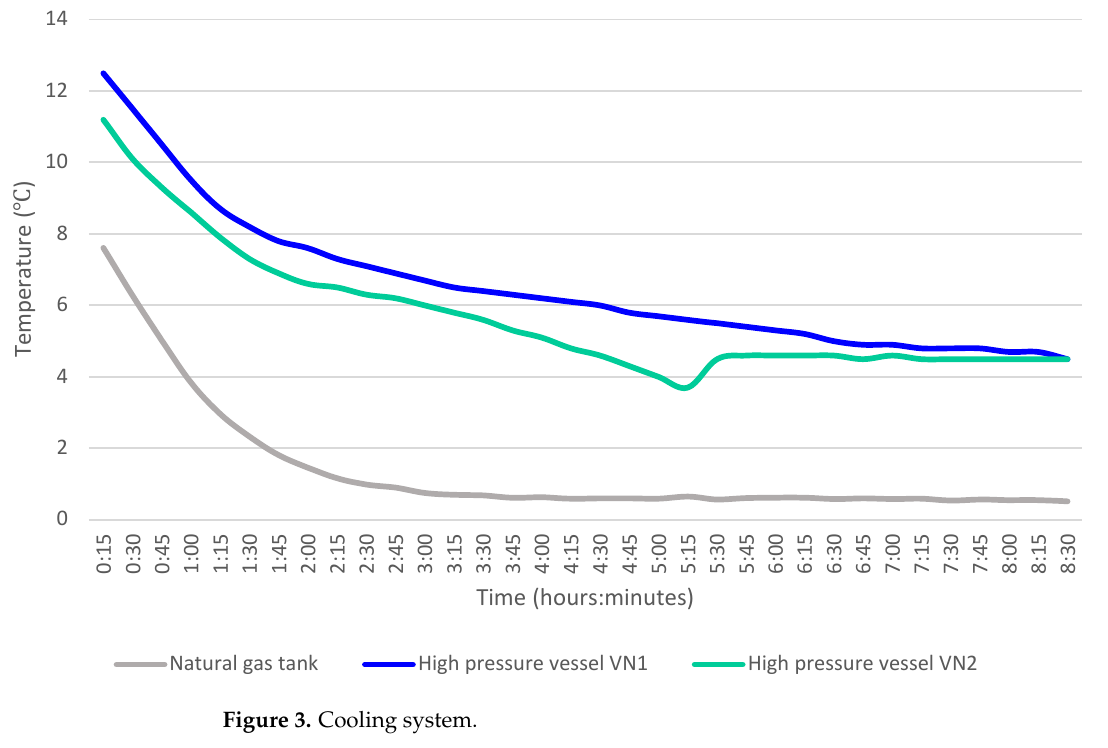
Figure 3. Cooling Figure 3. Cooling system.